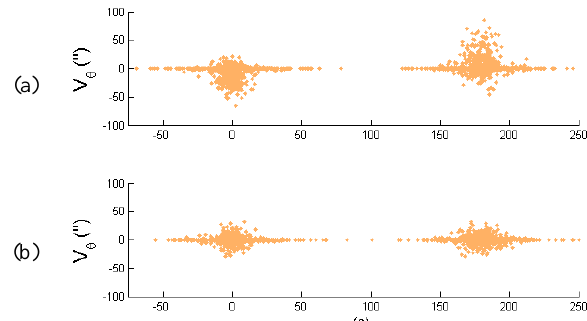
Figure 9: (a) Unmodelled 1’ collimation axis error. (b) After plane-based self-calibration.